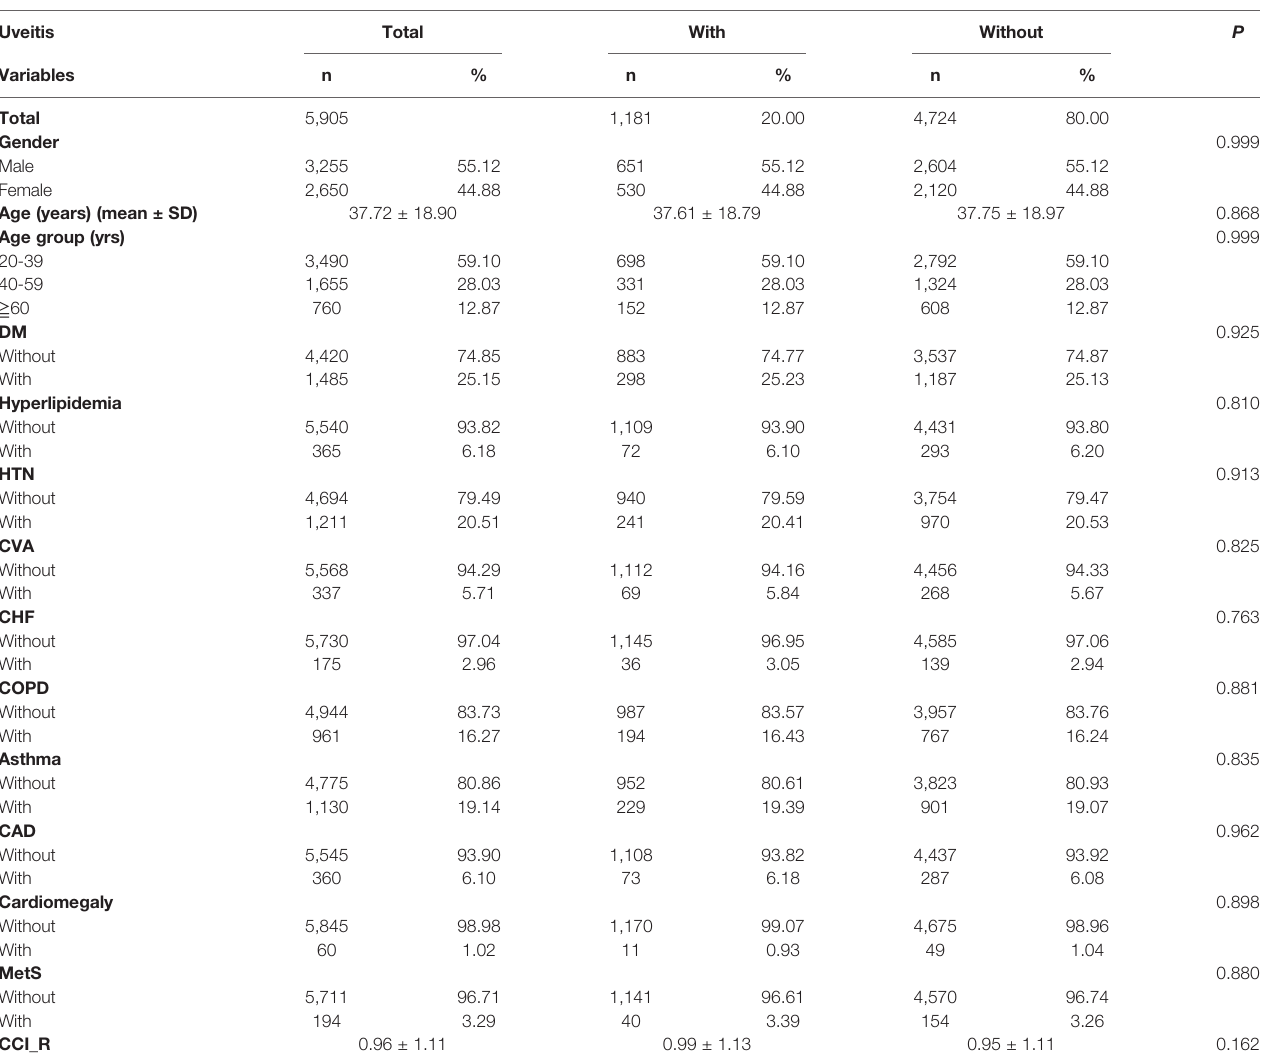
TABLE 1 | Patients ’ clinical characteristics at baseline. Uveitis Total With